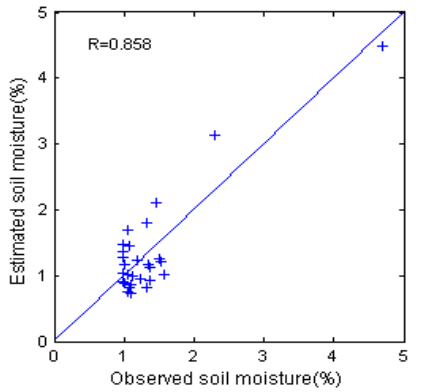
Figure 2. The relationship between observed and estimated soil moisture of